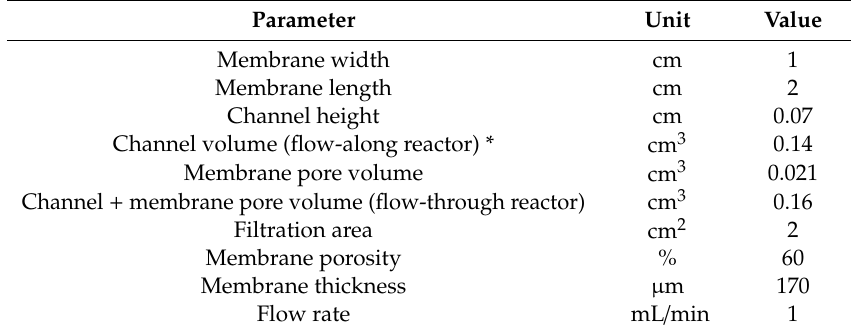
Table 2. Information about the membrane and the cell parameters in the experiments used for the residence time